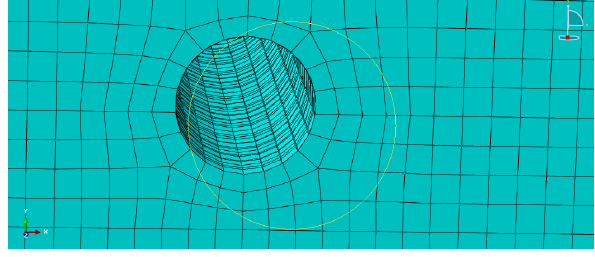
Figure 11: Finer mesh around the tunnel